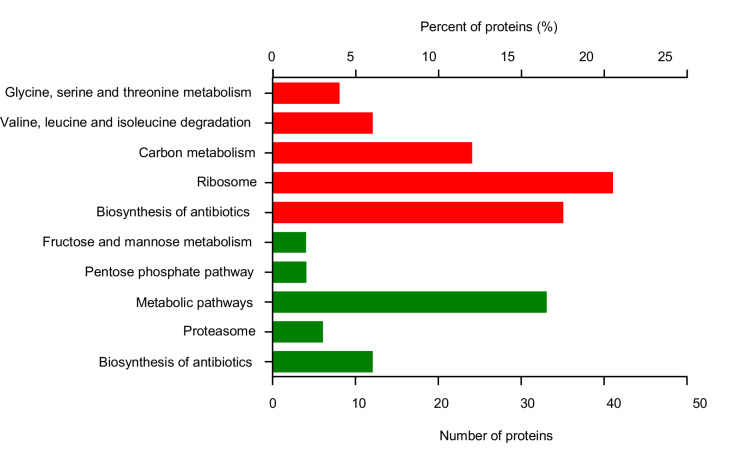
KEGG pathway analysis of differentially expressed peptides upon HFD feeding.Wild-type virgin female flies were fed with ND or HFD for 5 d before their hemolymph harvested and subjected to LC-MS/MS. The highly influenced KEGG pathways were shown (red: up-regulated by HFD; green: down-regulated by HFD).